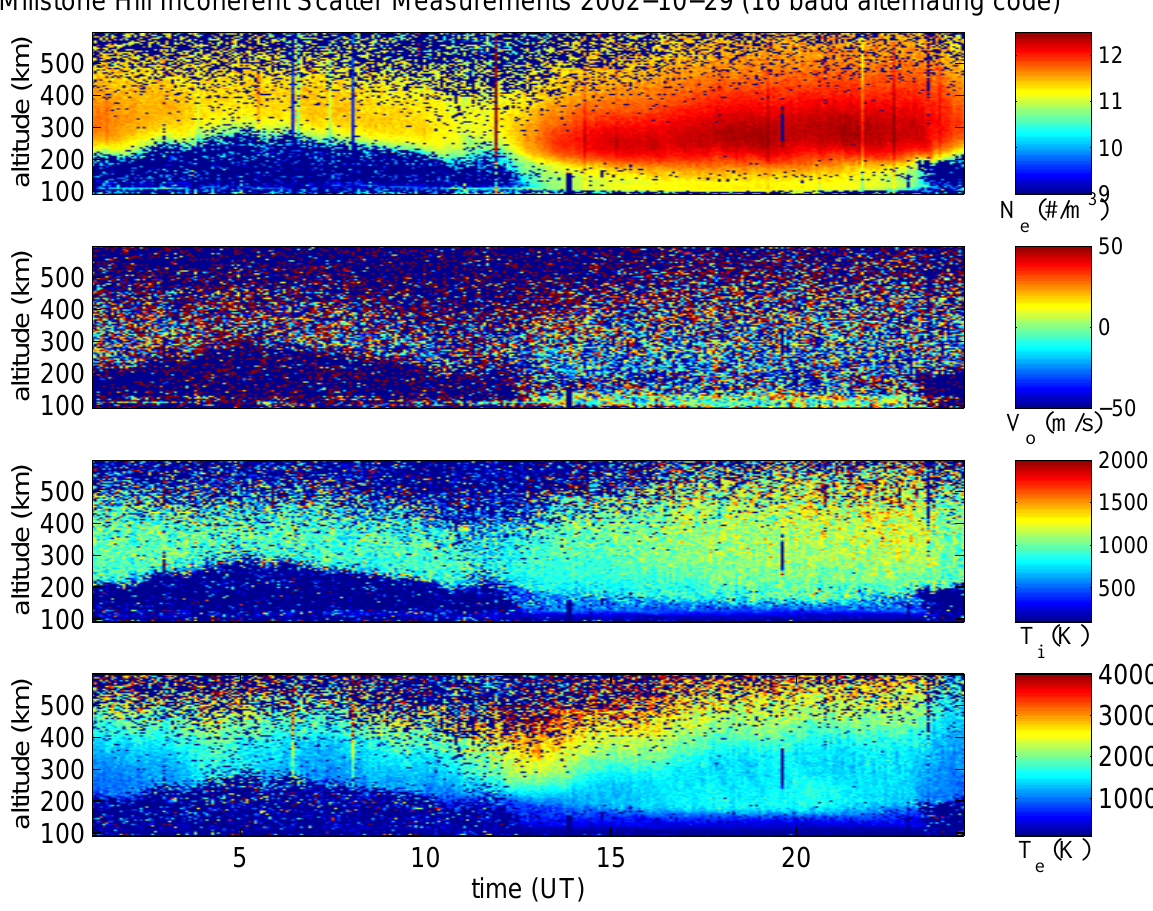
Fig. 11. An example of Millstone Hill alternating code data processed and fitted covering the E- and F-regions of the ionosphere over the course of a day. Here a sixteen-baud strong alternating code is used with a 30 µ s baud and an overall pulse length of 480 µ s. This code was interleaved with the corresponding single pulse during radar operations to allow for different measurements with simultaneous averaging centers to be made. Clutter subtraction was enabled for the processing, resulting in the recovery of E-region data. To allow for clutter subtraction, each alternating code sequence was sent twice and the return signals were subtracted at the voltage